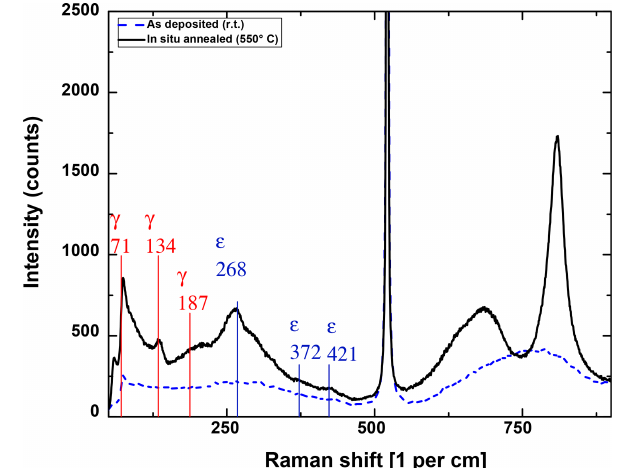
Figure 2. Raman spectra for undoped WO 3 layers deposited at room temperature (blue, dashed) and at 550 ◦ C (black,